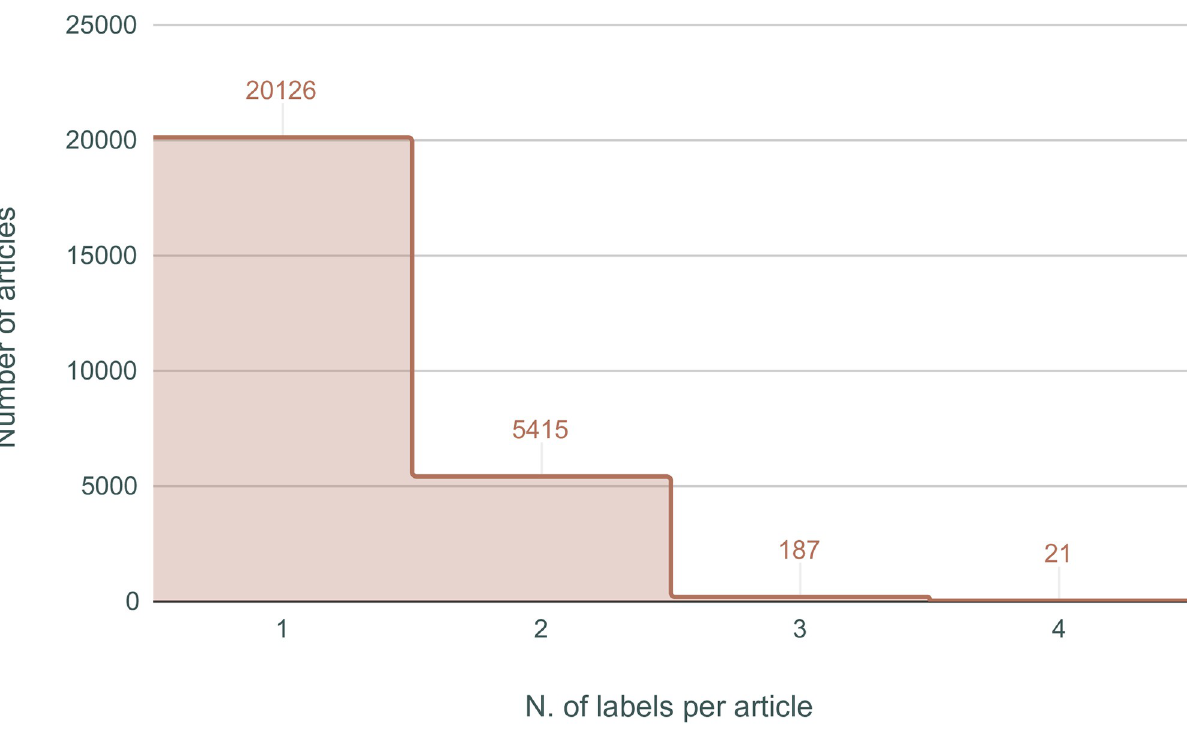
Fig 4. Distribution of the number of labels in RCV2it.